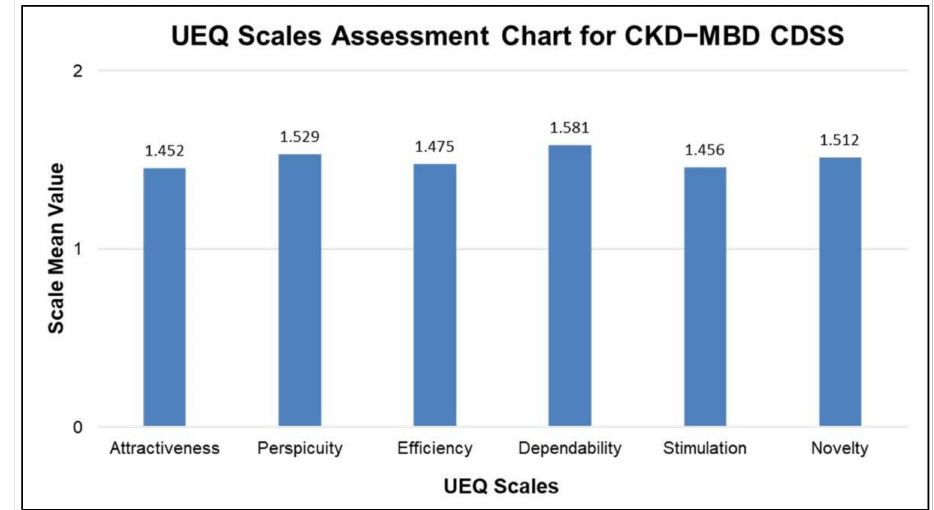
Figure 15. User Experience Questionnaire (UEQ) scale values for key 6 aspect dimensions.